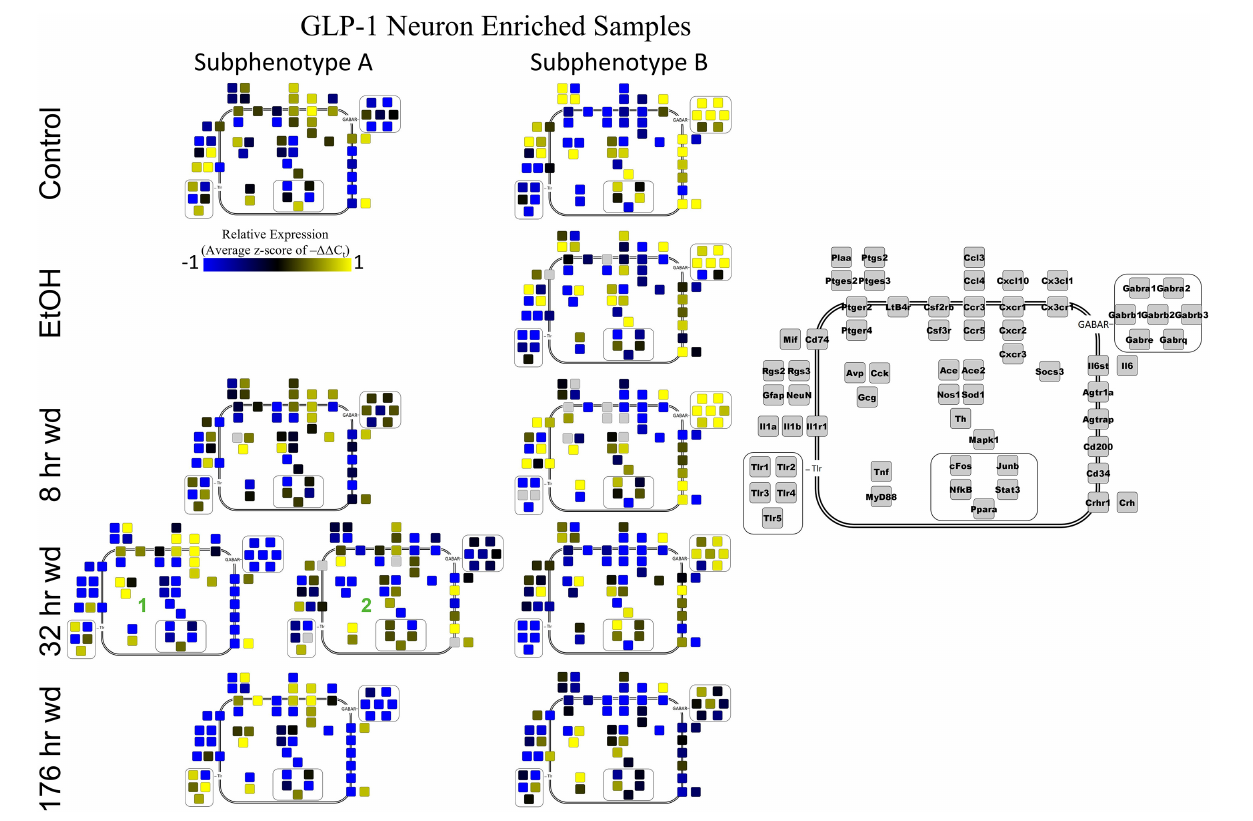
FIGURE 7 | Subphenotype Gene Expression in GLP-1 Neuron Enriched Samples. Cellular diagrams display boxes representing relative gene expression (average z-score of – (cid:49)(cid:49) C t values) of subphenotypes shown in prior heatmaps. Legend with gray boxes in on right of figure labels which boxes correspond to which gene. Box color represents expression (blue is low expression and yellow is high expression). The location of the box represents the localization or function of the protein product from that gene transcript. Green numbers indicate subgroups within subphenotypes. Group C shown in Supplementary Figure 5